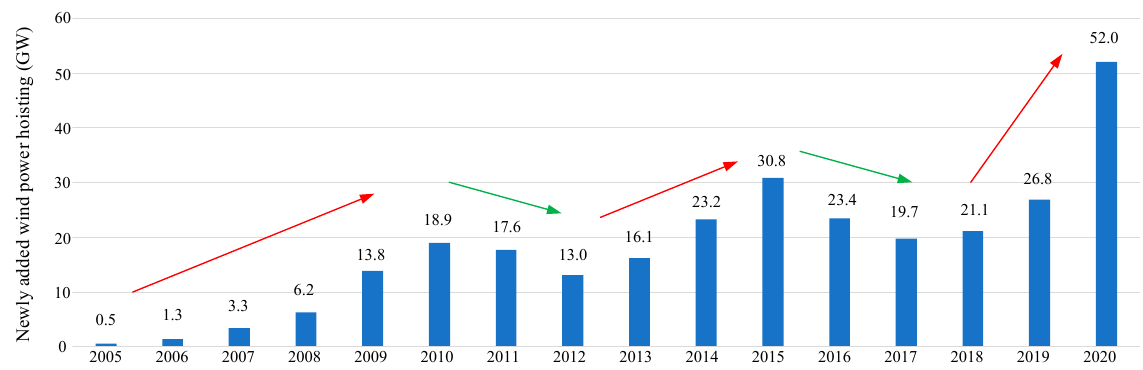
Figure 14. Domestic newly added wind power hoisting